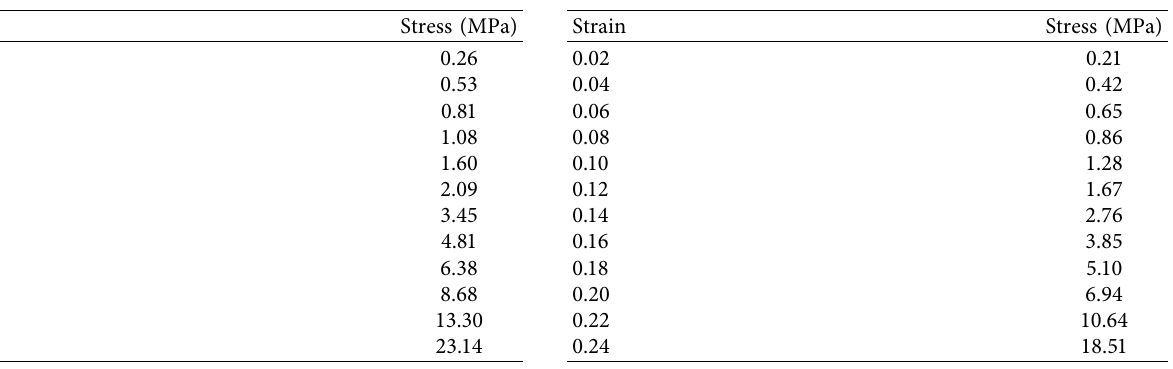
Figure 9: The structural diagram of the checking calculation. Table 2: Cap pressures used in the double yield model. Table 3: Cap pressures used in the double yield